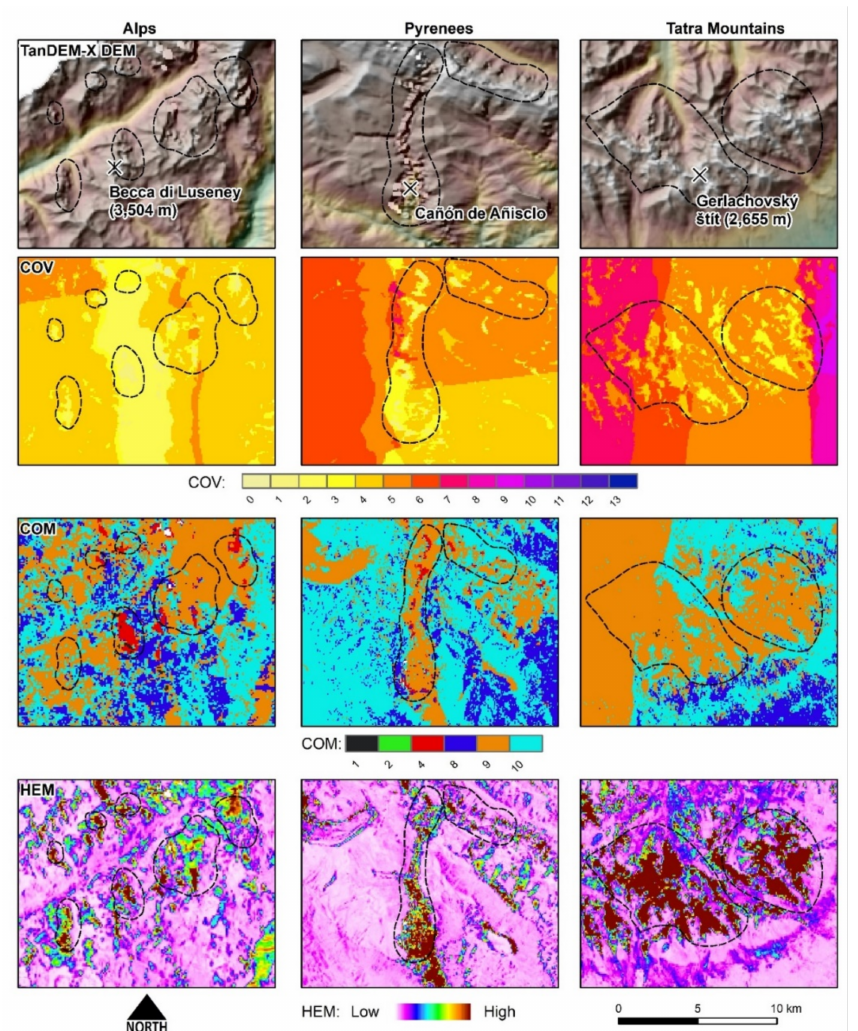
Figure 5. Auxiliary TanDEM-X data of the three problematic sites of low TDX90 quality: the Alps ( left ), the Pyrenees ( middle ), and the Tatra Mountains ( right ). The most problematic sites are delimited with a dashed line. Visual assessment of the auxiliary data suggests that they can indeed be used to identify sites of low TDX90 quality. Note that the problems are mostly located in the areas of low coverage (COV), larger inconsistencies (COM = 9), and high estimated height error